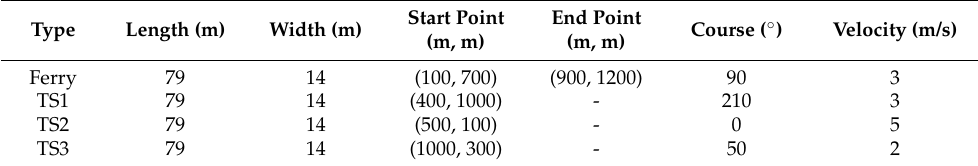
Table 1. Simulated parameters.